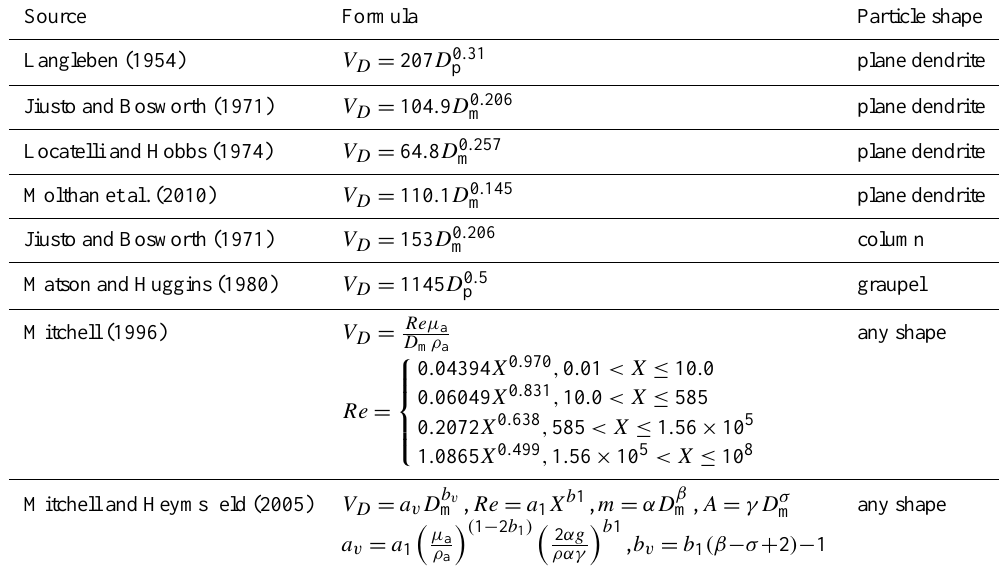
Table 3. List of empirical and theoretical snow-particle terminal velocity (cms − 1 )